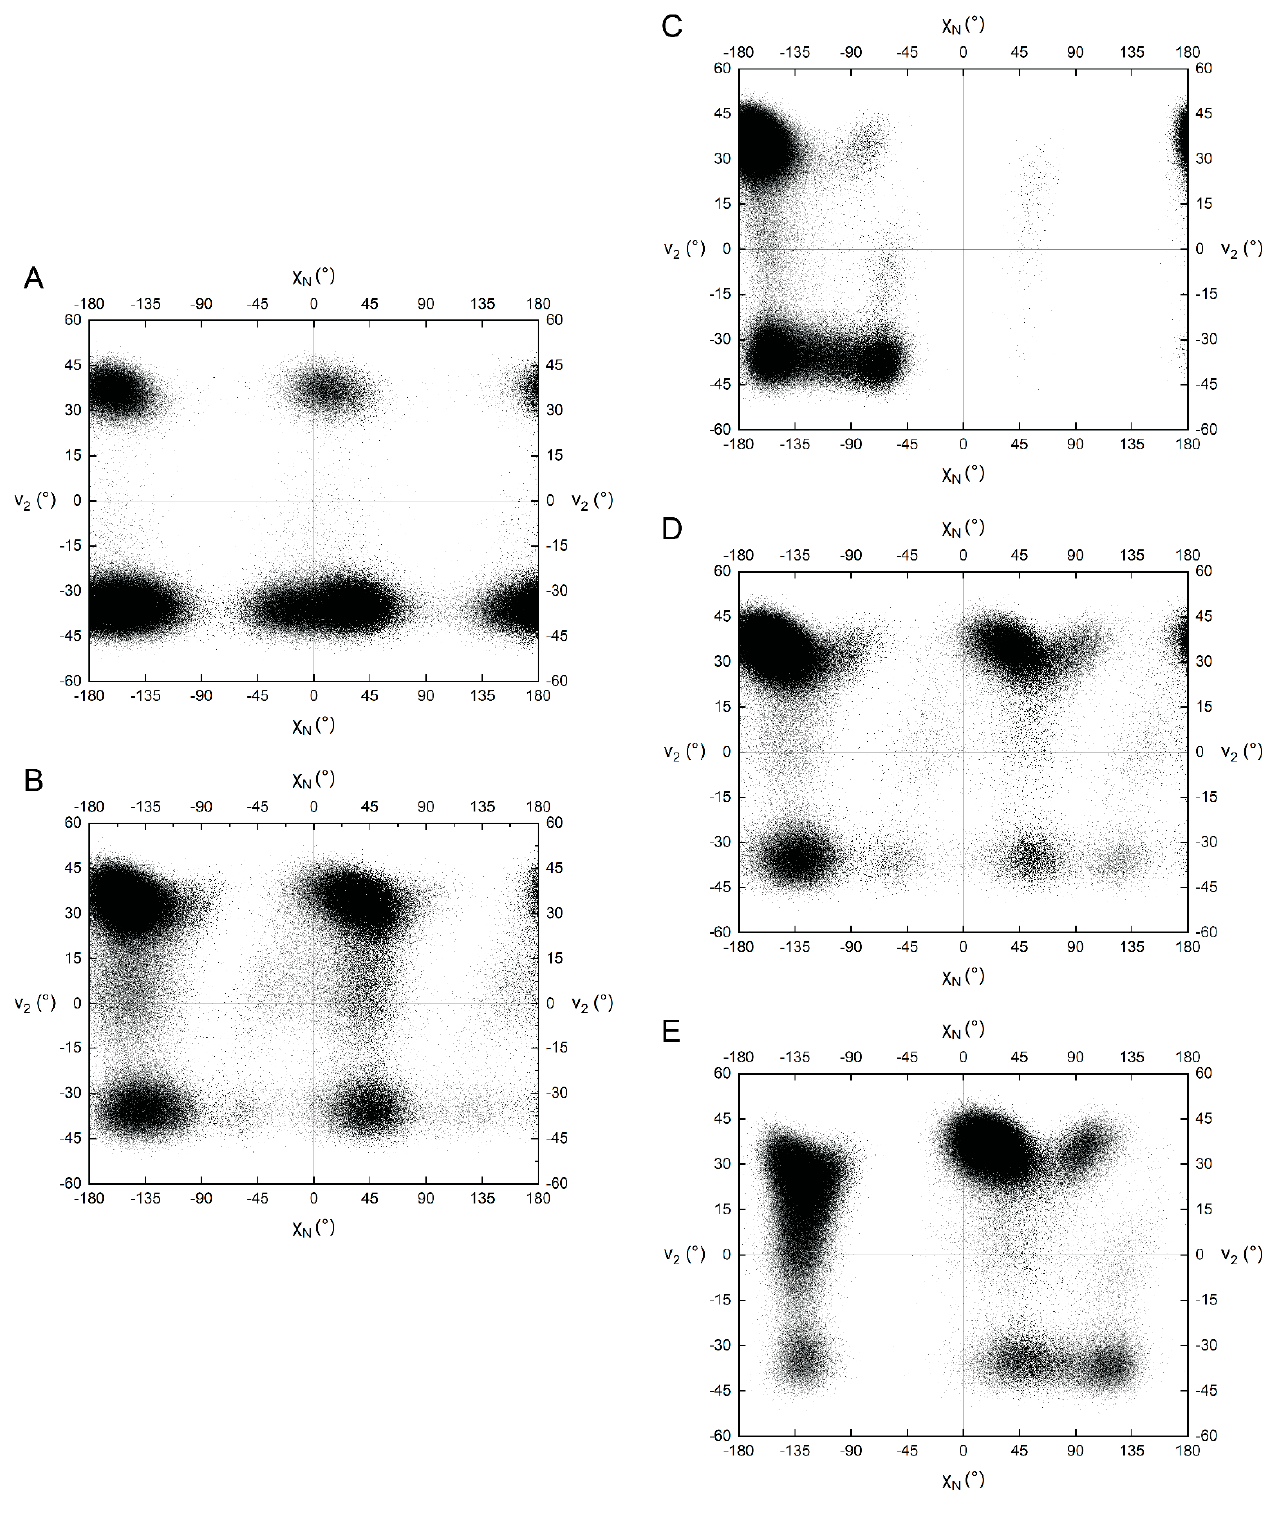
Figure 7. Scatter plot of the nicotinamide/pyridone ribose dihedral angle (v 2 ) versus nicotinamide/pyridone glycosidic bond dihedral angle ( χ N ) for ( A ) NAD + , ( B ) NADH, ( C ) 2-ox-NAD, ( D ) 4-ox-NAD, and ( E ) 6-ox-NAD.